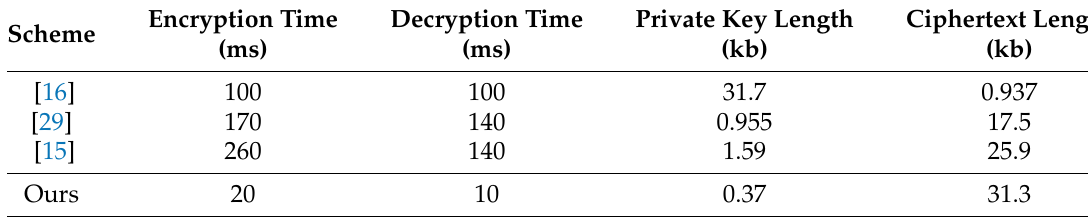
Table 3. Implementation